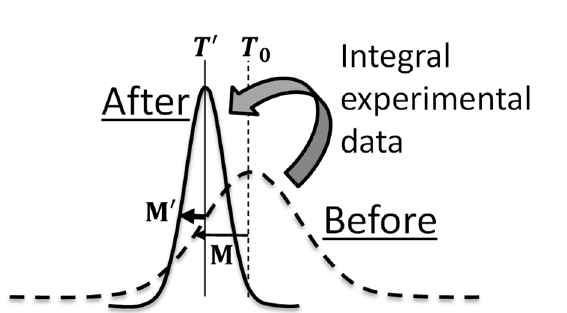
Fig. 1. Concept of cross-section